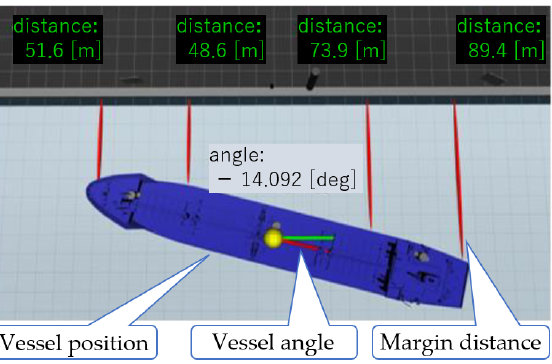
Figure 7. One scene of our visualization interface simulated with distance data.